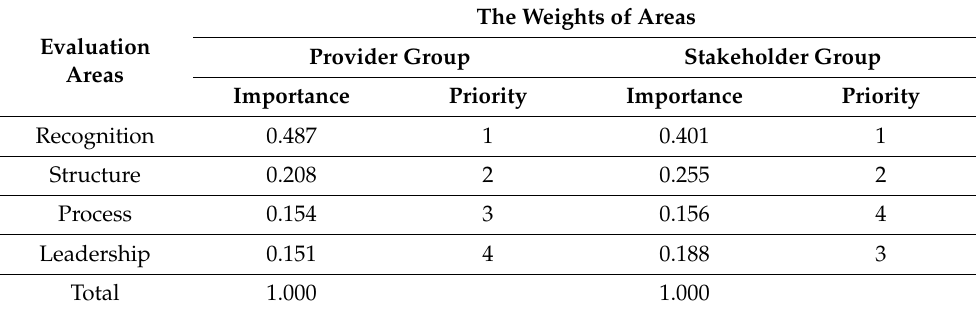
Table 7. Comparison analysis result on evaluation